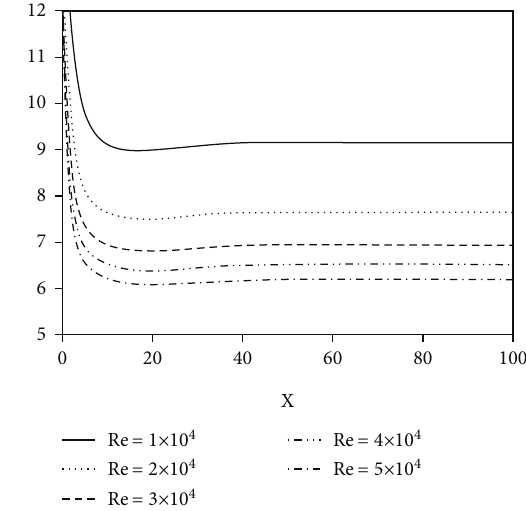
Figure 7: Local skin friction coe ffi cient along the channel.